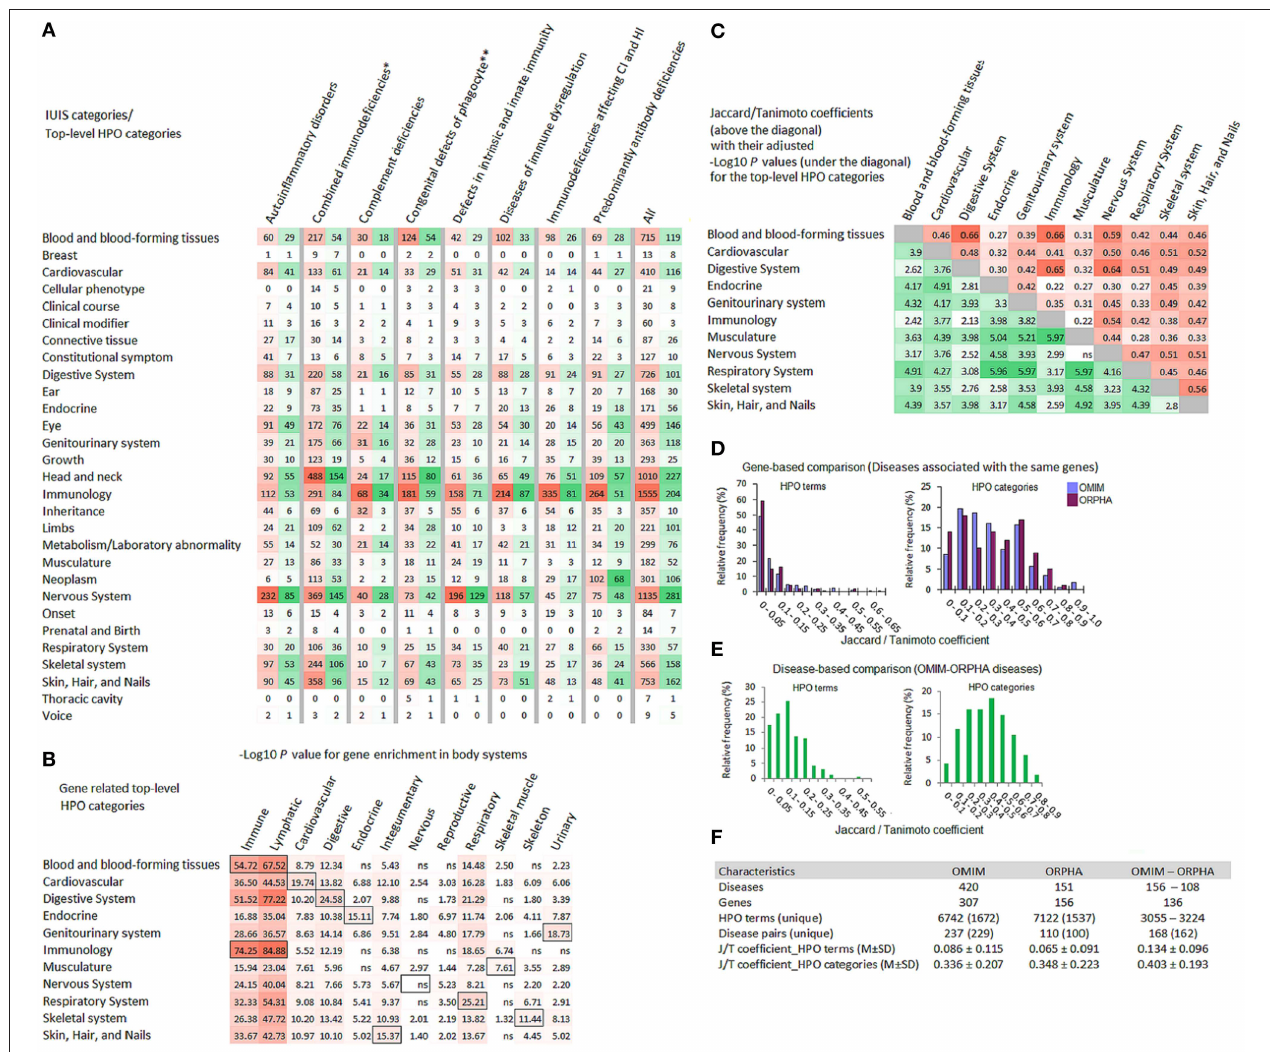
FIGURE 2 | HPO annotations for the genes associated with inborn errors of immunity. (A) Multiple heat-map matrix for HPO terms related to top-level HPO categories (Y-axis) in the diseases grouped by the IUIS categories (X-axis). Since many HPO terms were associated with several genes, the data are presented as sum of their occurrences, i.e., the total number (red) and unique number (green) of HPO terms. For the IUIS categories all heat-maps are independent to each other. (B) Heat-map matrix for the results of Gene ORGANizer enrichment analysis. Gene lists related to top-level HPO categories (Y-axis) were analyzed for their overrepresentation in body systems (X-axis). FDR adjusted enrichment P values (threshold < 0.05) represented as –Log10 (threshold > 1.30) are plotted against HPO categories. Cells with P values for body systems matched with HPO categories are highlighted with black boundaries. (C) Heat-map matrix for the genetic similarity between selected top-level HPO categories. Jaccard/Tanimoto coefficient values are colored in red; their FDR adjusted P values represented as –Log10 are colored in green. (D) The Jaccard/ Tanimoto coefficient distribution for HPO terms and top-level HPO-categories for OMIM and ORPHANET diseases associated with the same genes. (E) The Jaccard/Tanimoto coefficient distribution for HPO terms and top-level HPO-categories for matched OMIM-ORPHANET disease pairs. (F) Summary statistics for the overlap measures. CI, cellular immunity; FDR, false discovery rate; HI, humoral immunity; J/T, Jaccard/Tanimoto; ns, non-significant; ORPHA, ORPHANET. *Combined immunodeficiencies with associated or syndromic features; **Congenital defects of phagocyte number or function.